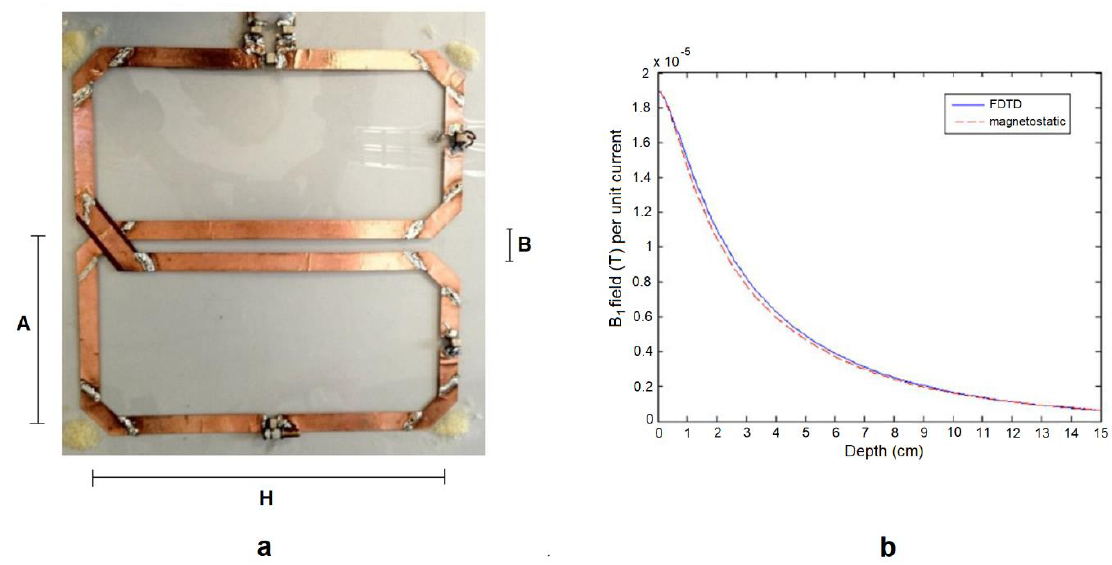
Figure 9. A butterfly coil. ( a ) Prototype picture; ( b ) Magnetic field pattern calculated with the finite-difference time-domain (FDTD) and magnetostatic methods. Adapted by permission from Giovannetti et al., Measurement 2013